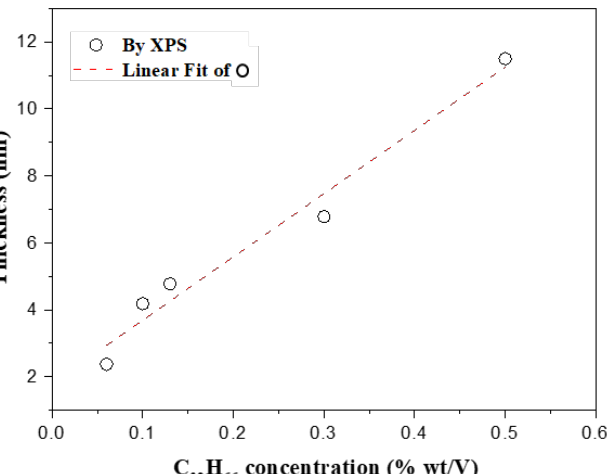
Figure 4. Thickness of C 32 H 66 thin films estimated from the XPS intensities as a function of its spin coating concentration.